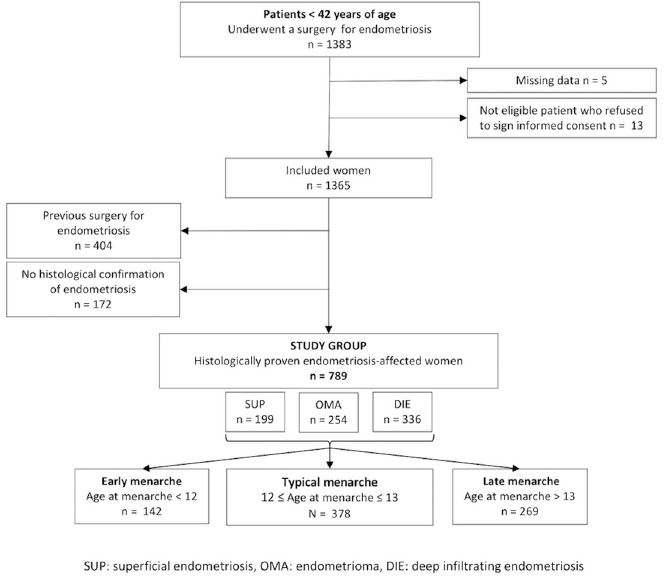
Fig 1. Flowchart outlining the selection process of patients operated for the first time for endometriosis. menarche: 13.0 ± 1.7, 12.9 ± 1.5, and 12.9 ± 1.5 years, respectively; p = 0.68, and time interval